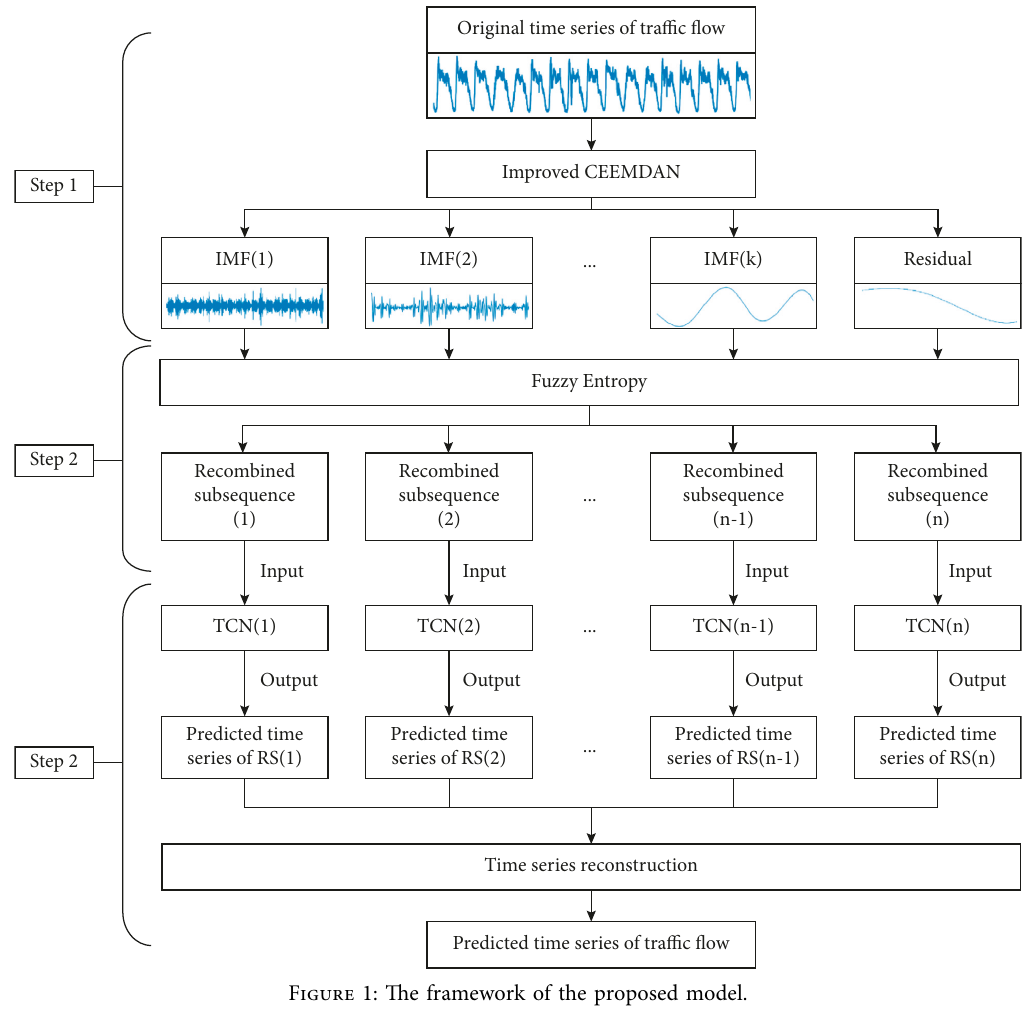
Figure 1: The framework of the proposed